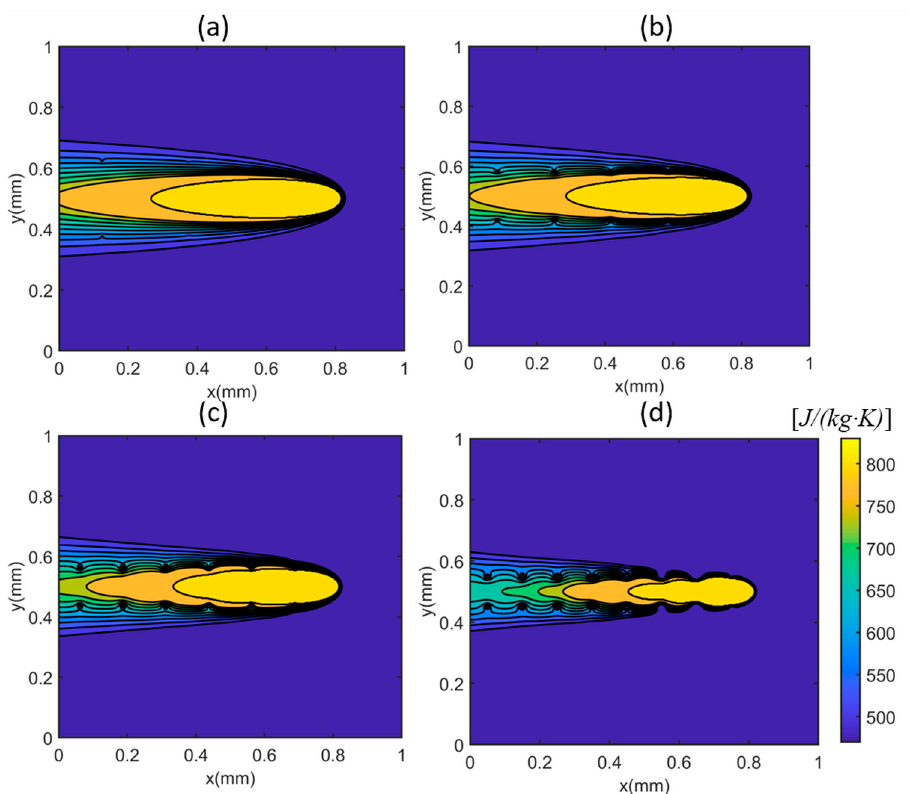
Figure 5. Calculated variations on specific heat due to the single-track scans with different numbers of heat sinks: ( a ) 4 × 4 = 16 heat sinks, ( b ) 6 × 6 = 36 heat sinks, ( c ) 8 × 8 = 64 heat sinks, and ( d ) 10 × 10 = 100. The moving laser is located at x = 0.8 mm, y = 0.5 mm.